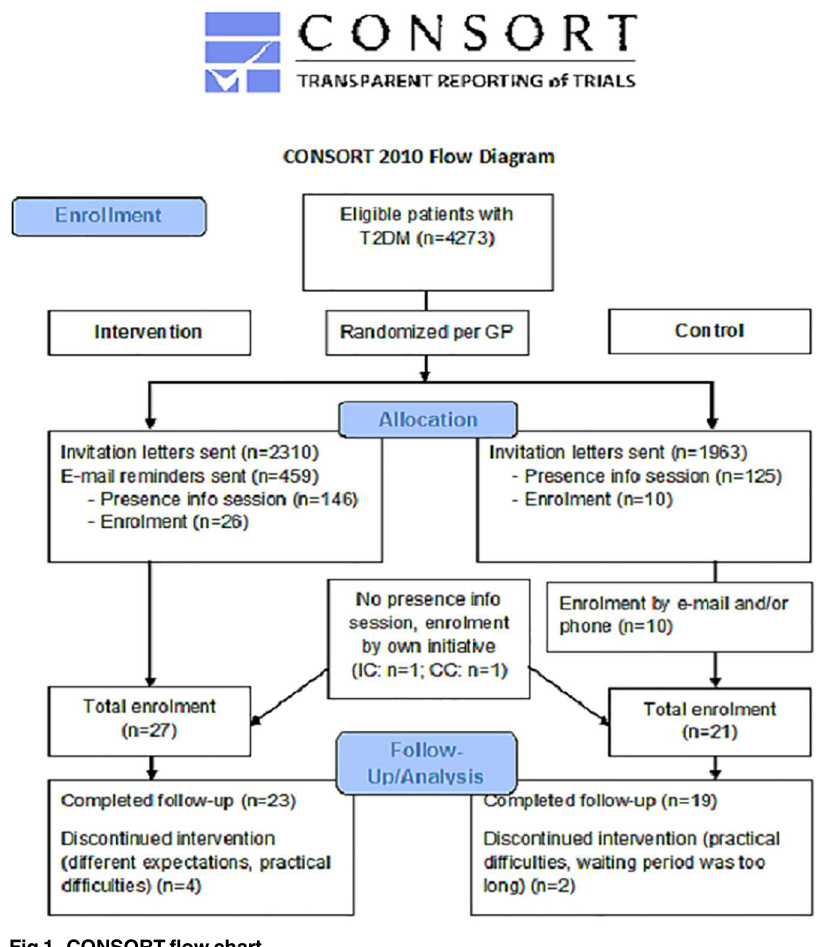
Fig 1. CONSORT flow